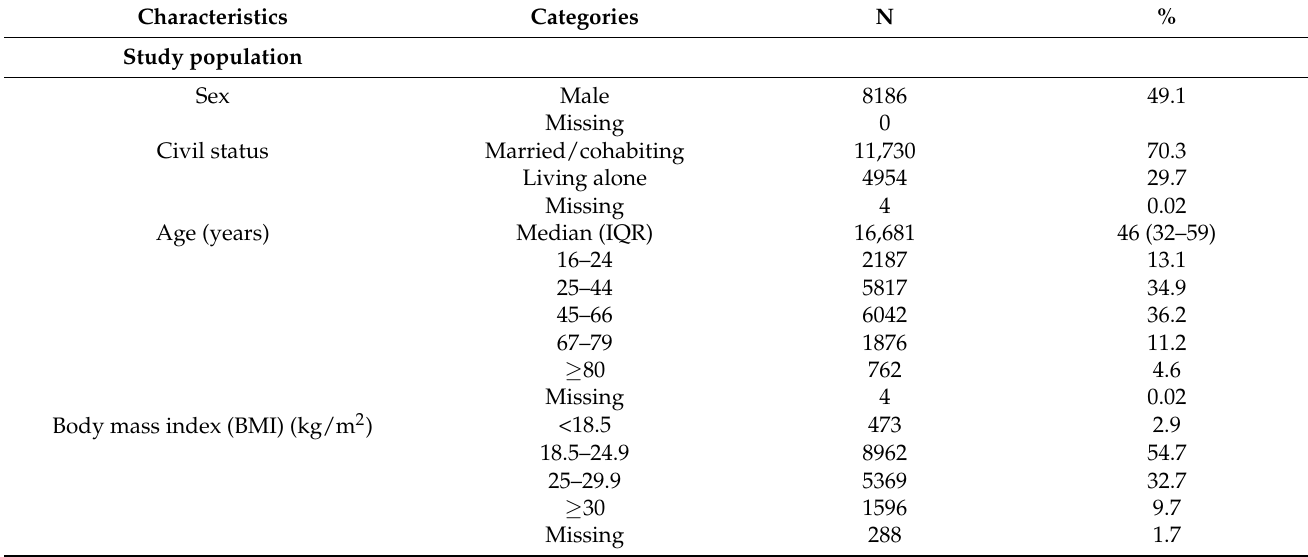
Figure 1. Study flow of participants. Table 1. Baseline characteristics of the study population and their dwellings, n =